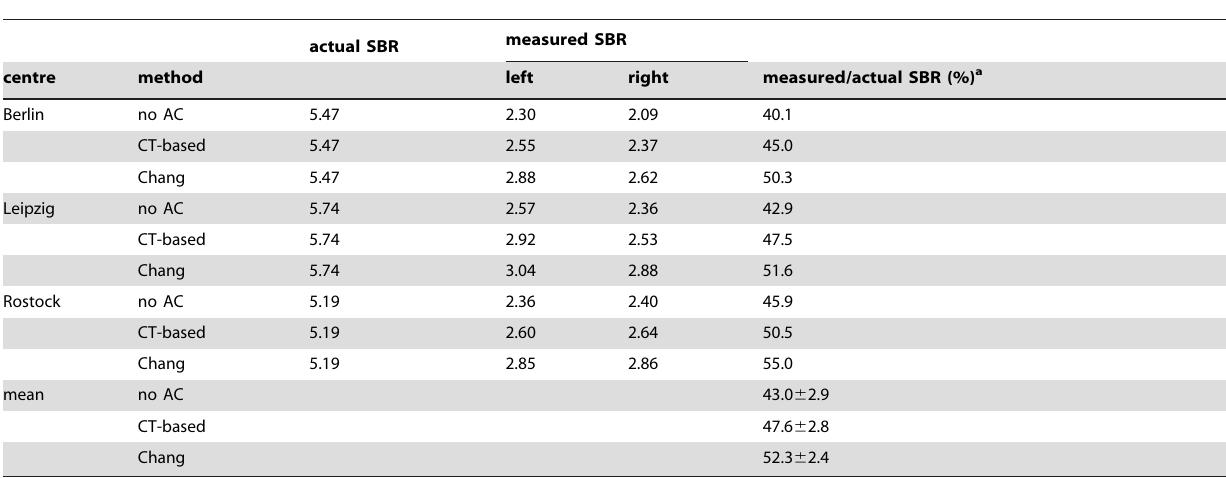
Table 1. Results of the semi-quantitative analysis of the phantom studies.